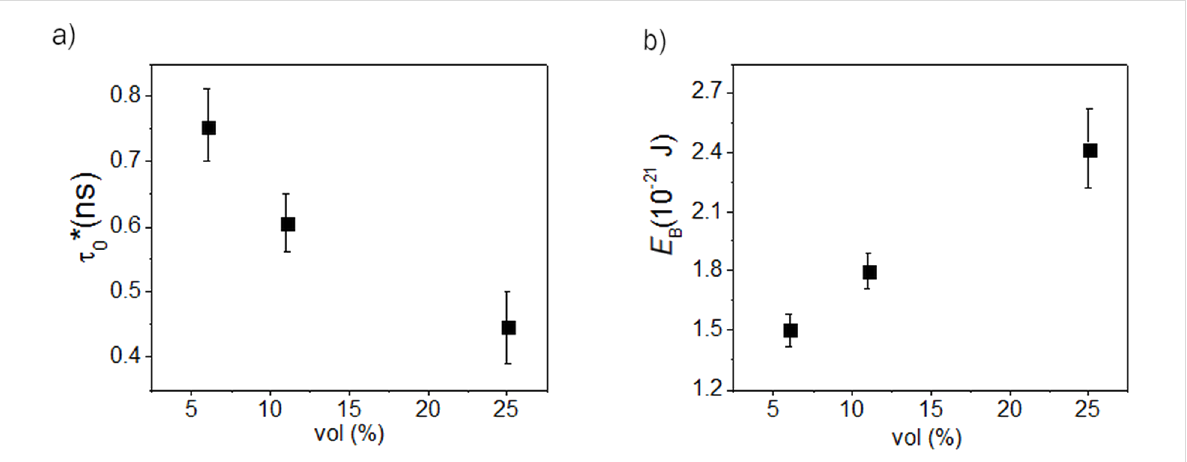
Figure 5: Relaxation time constant (a) and anisotropy energy barrier (b) of an inner MNP versus the volume fraction in %, as estimated from the theo- retical simulations.